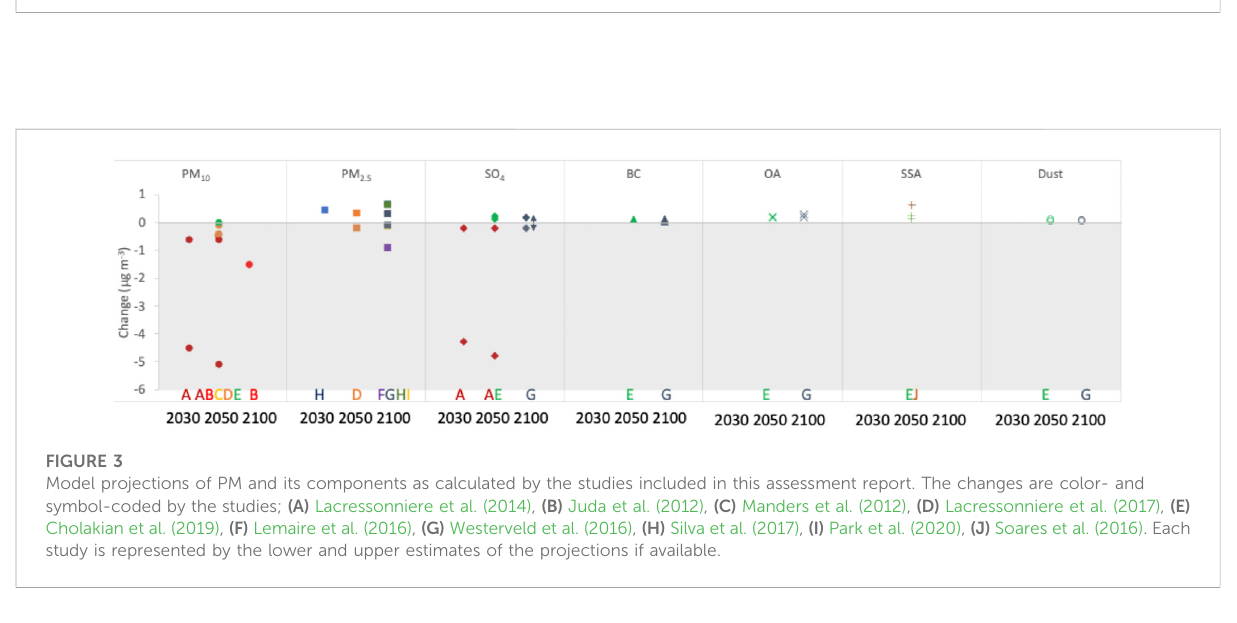
FIGURE 2 Model projections of O 3 as calculated by the studies included in this review, based on Fu and Tian. (2019). The changes are color- and symbol- codedbythestudies; (A) Watsonetal.(2016), (B) Fortems-Cheineyetal.(2019), (C) Glotfeltyetal.(2016), (D) Coletteetal.(2015),and (E) Schnelletal. (2016). Each study is represented by the lower and upper estimates of the projections if available.